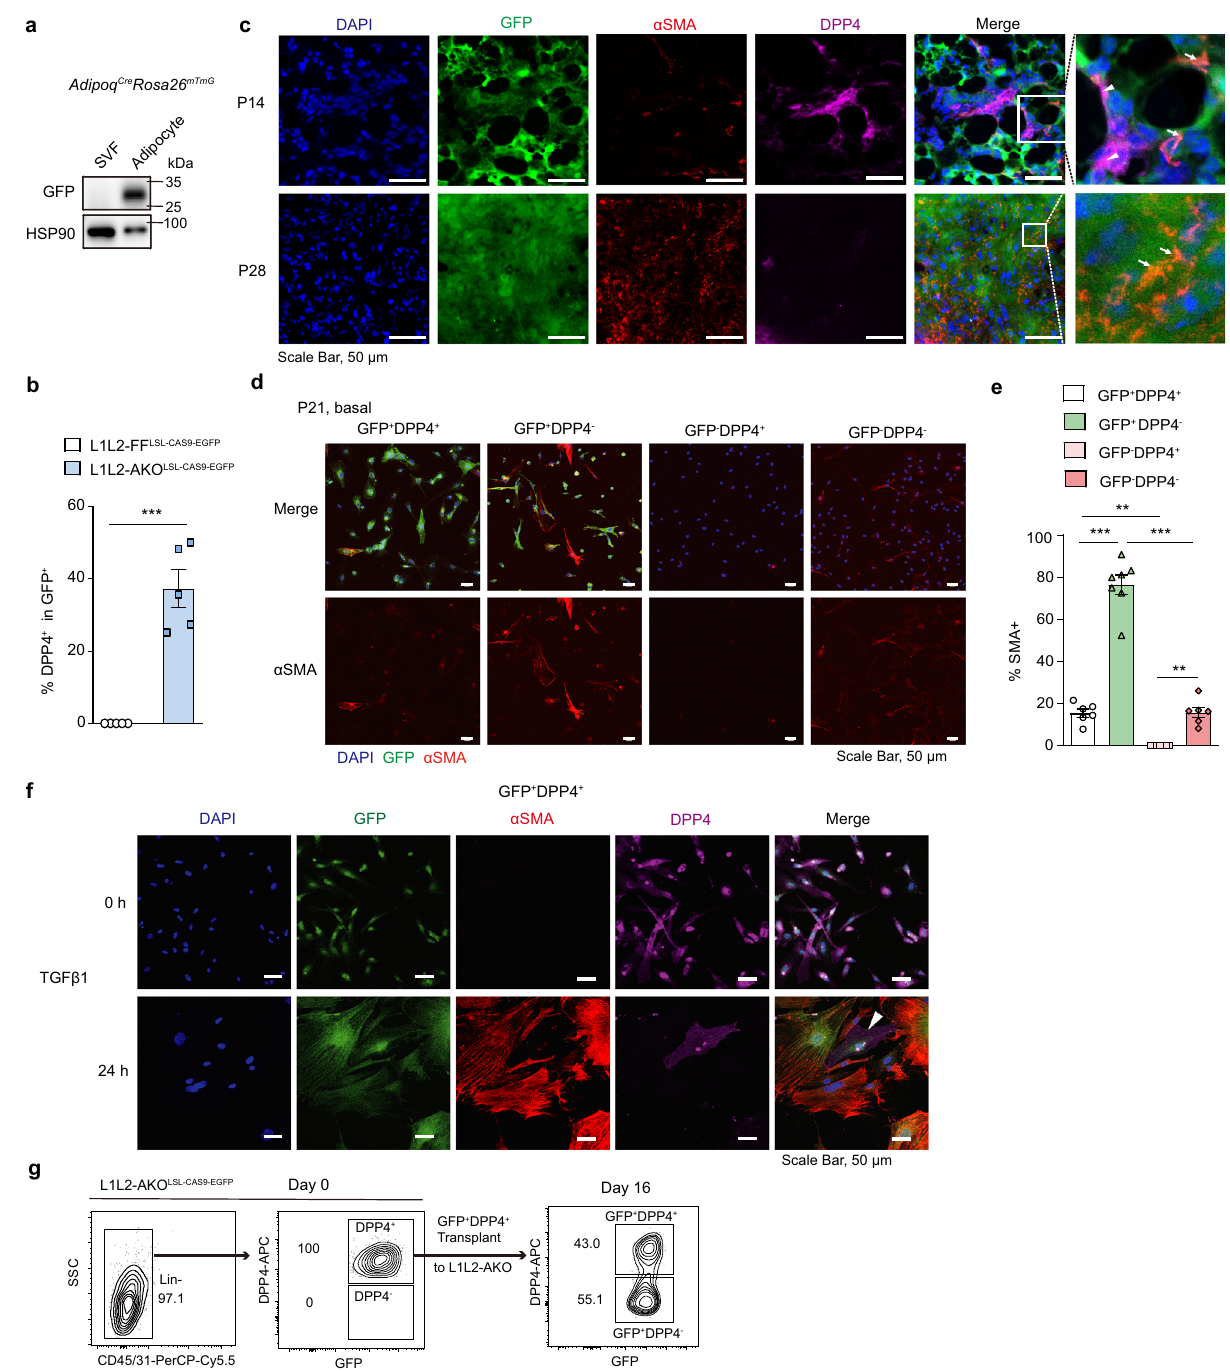
Fig. 5 | Lats1/2 de fi ciency promotes cell fate conversion from adipocytes to myo fi broblasts. a Immunoblot analysis of protein expression of GFP in SVF and adipocyte from 8-week-old Adipoq Cre Rosa26 mTmG scWAT. Independent experiments were performed twice with similar results. b Flow cytometry analysis of percen- tages of live CD45 − CD31 − GFP + DPP4 + cells in scWAT SVF of P21 L1L2-FF LSL-CAS9-EGFP or L1L2-AKO LSL-CAS9-EGFP reportermice( n =5). c RepresentativesectionsofscWATofP14 or P28 L1L2-AKO LSL-CAS9-EGFP mice stained for α SMA (red), DPP4 (purple), nucleus (DAPI, blue) and GFP (green). Arrowheads indicate examples of GFP + DPP4 + cells. Arrows point to GFP + α SMA + cells.Independentexperiments wereperformedthree times with similar results. d Sorted cellsubsets from P21 L1L2-AKO mTmG scWAT SVF were plated and stained for α SMA (AF647, red) and nucleus (DAPI, blue). e Quanti fi cation of percentages of GFP+DPP4+ ( n =6), GFP+DPP4- ( n =7), GFP- DPP4+ ( n =7), GFP-DPP4- ( n =7) cells. Dots represent cell percentages of random